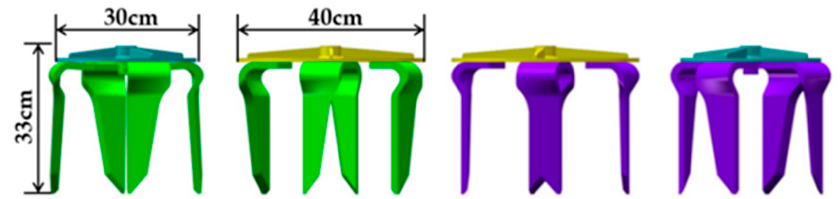
Figure 6. Vertical rotary cutter set model.